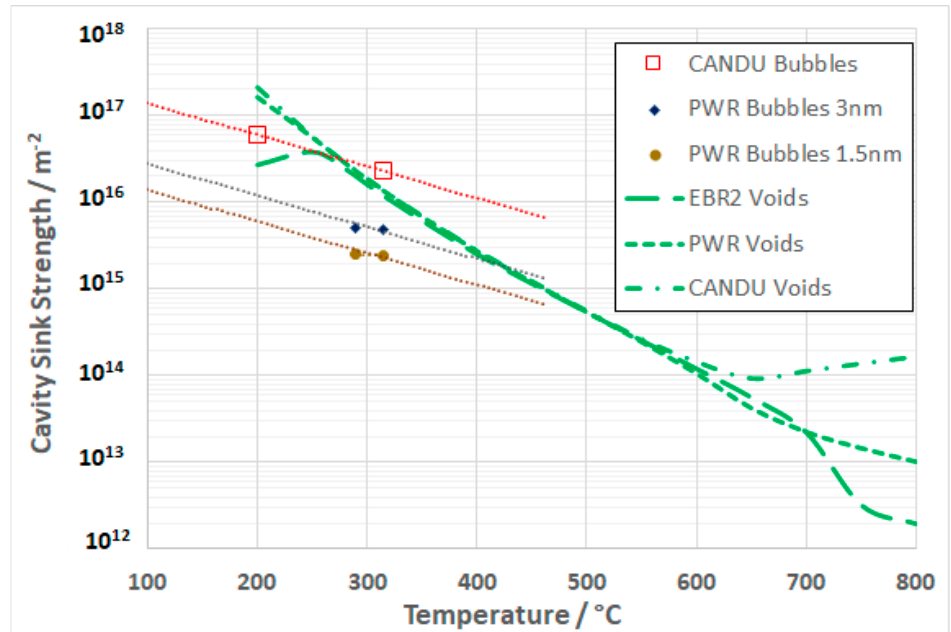
Figure 13. Sink strengths (= 4 π D ρ ) , where ρ is the cavity number density and D is the diameter, of Inconel X-750 in CANDU reactor and 316 SS in a PWR extrapolated to 100 DPA as a function of temperature. Also shown are the sinks strengths for voids calculated for various reactors at 100 DPA.